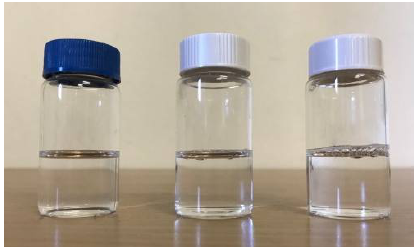
Figure 2. Fx/CyA-ASNg dispersions containing 0.10 ( left ), 0.15 ( center ) and 0.20% w / w ( right ) of GG-LA. Table 4. Size, polydispersity index (PI), CyA-In, EE, LE, cloud point (CP) and regeneration time (RT) of developed Fx/N2CyA-ASNg (mean, n =